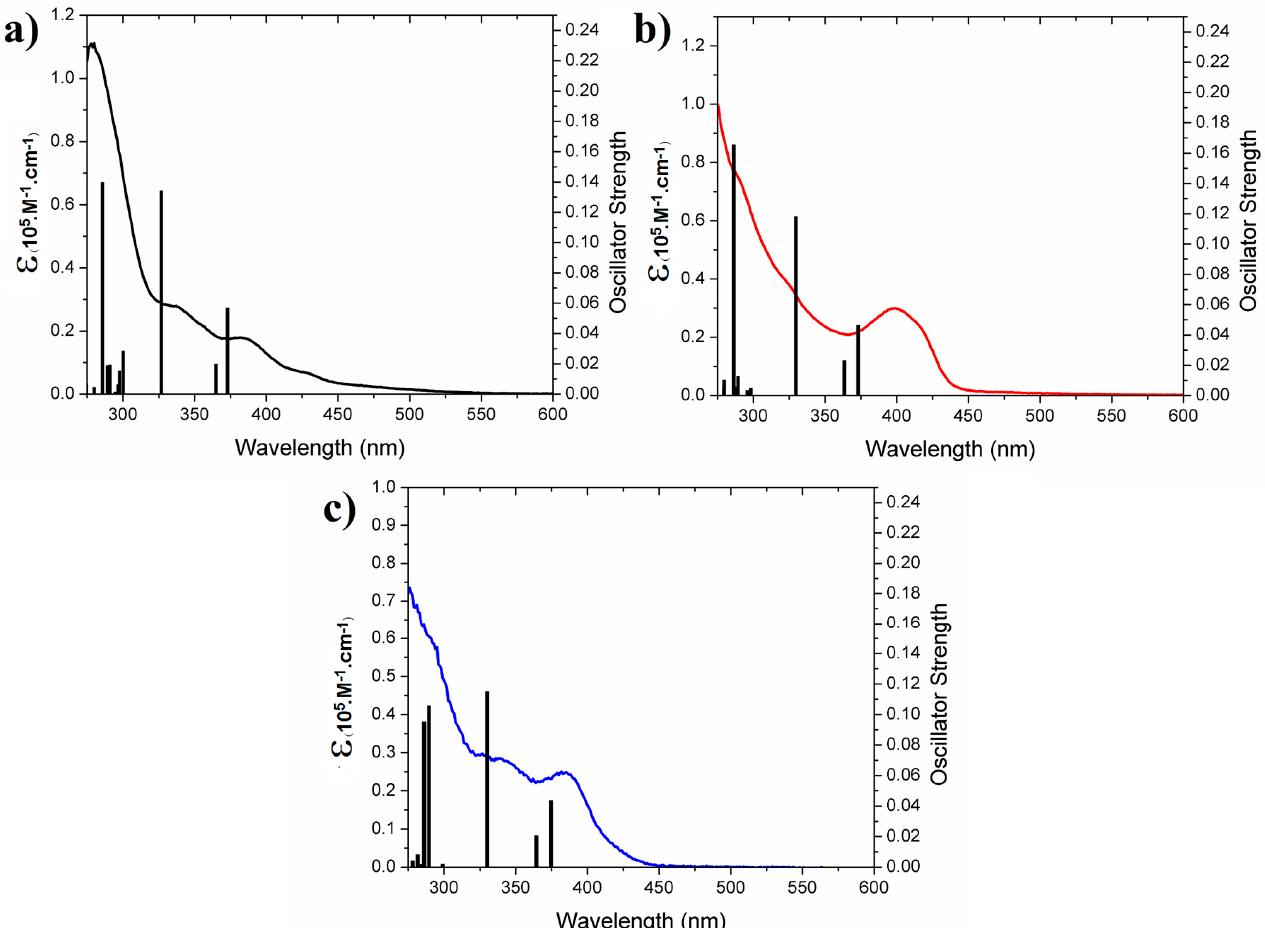
Figure 2. Overlaid experimental UV-vis spectra (10 − 5 M) and theoretical time-dependent density functional theory (TD– DFT) bars for ( a ) 1a , ( b ) 1b , and ( c ) 1c .